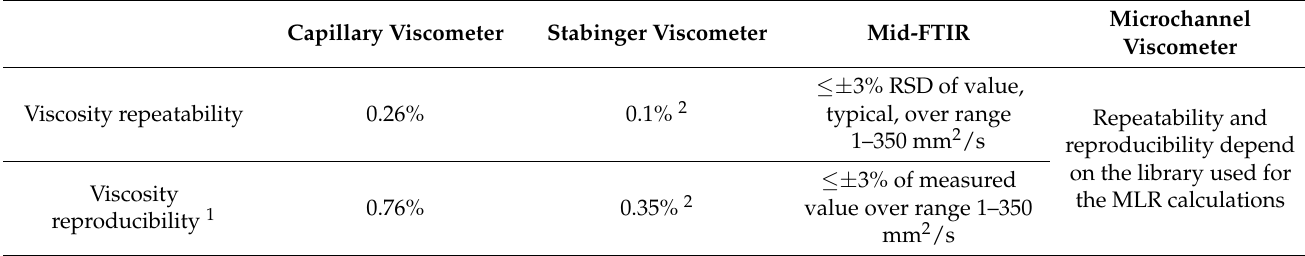
Table 2. Measurement repeatability and reproducibility—declared by